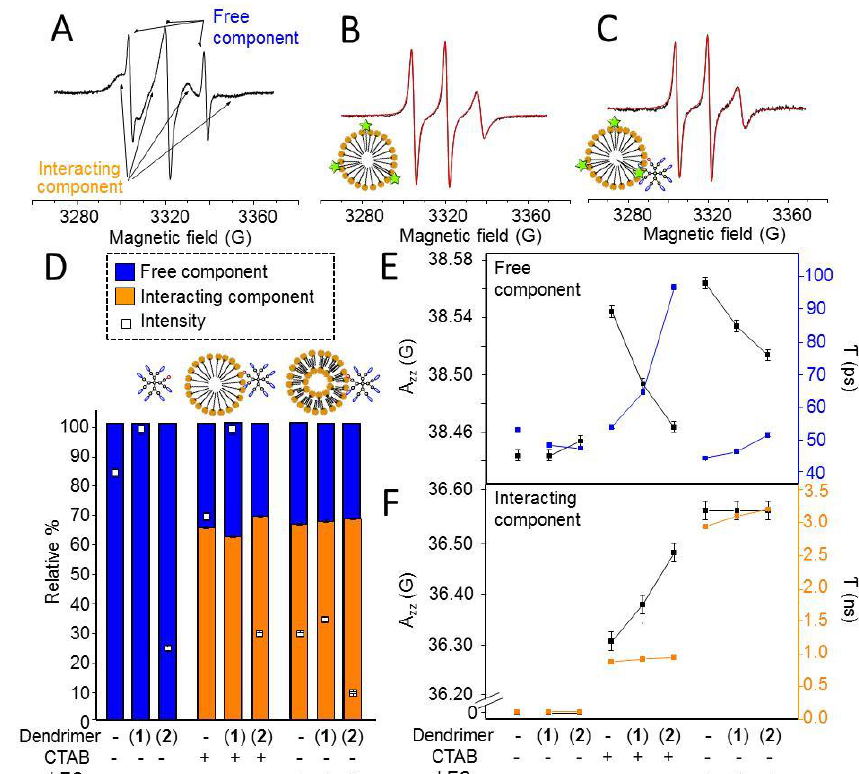
Figure 4. Experimental spectra and computation spectra / parameters for the CAT12 EPR spectra of the unlabeled heterofunctional dendrimers G n -PyN in the absence and presence of the model membranes (CTAB micelles and LEC liposomes). ( A ) EPR spectrum of CAT12 for G 1 -PyN ( 1 ) in the presence of LEC; ( B, C ) experimental (black) and computed (red) spectra of the interacting component for CAT12 in CTAB sample, alone and in the presence of G 2 -PyN ( 2 ); ( D ) Relative percentage of Interacting component (bars), and total intensity (squares) as a percentage, where 100% intensity was ascribed to the spectrum at the highest intensity; ( E, F ) A zz values (left axis) and τ values (right axis) for the Free and the Interacting components. PBS sample was evaluated in the absence of dendrimers and model membranes.